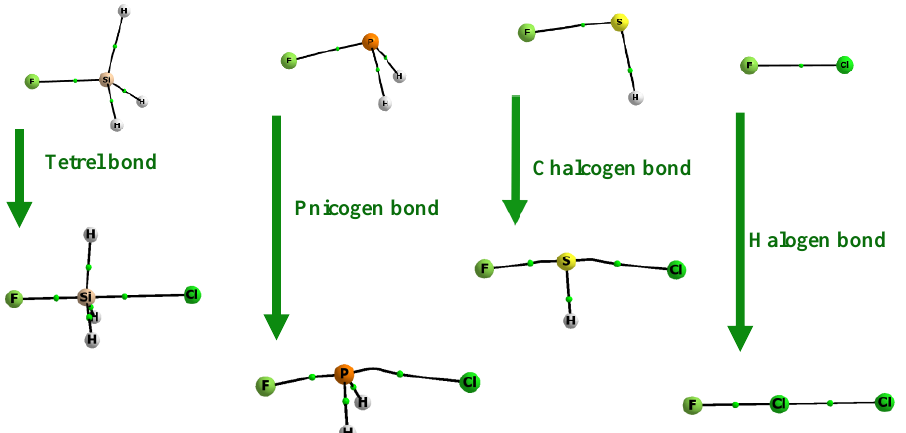
Figure 3. Molecular graphs of the Lewis acid units and the corresponding complexes (Z centre is of the third row of the periodic system). The big circles correspond to attractors (related to the atoms ’ positions) and the small green circles to bond critical points; attractors are connected by bond paths.